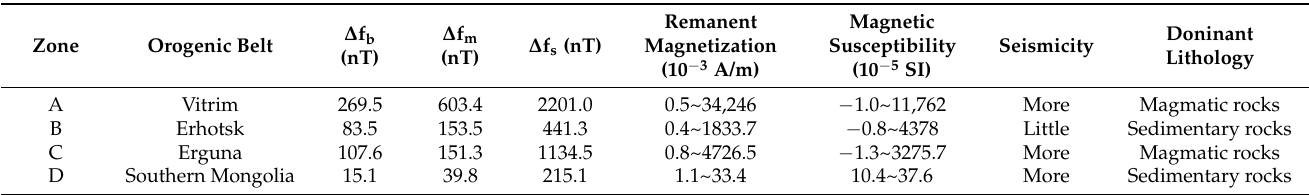
Table 2. Comparison of the lithospheric magnetic anomalies and factors such as the regional geologi- cal structure, rock remnant magnetization, susceptibility, earthquake activity, and rock properties among the four regions A, B, C, and